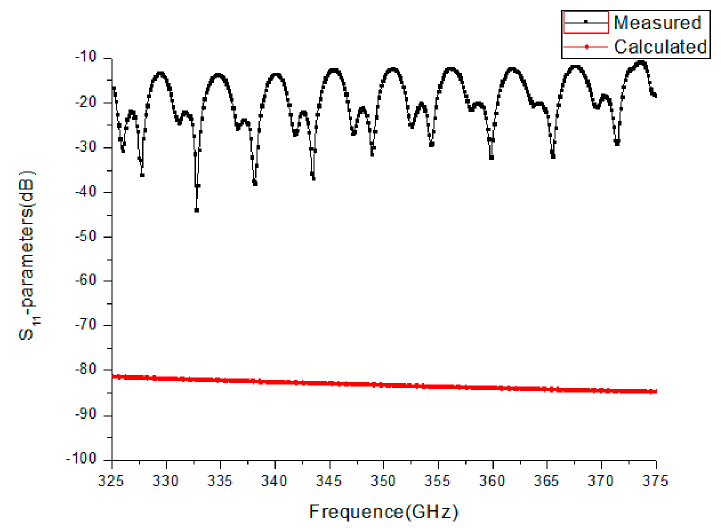
Figure 15. The experimentally measured S 21 and calculated S 21 parameters of the WR2.8 waveguide.